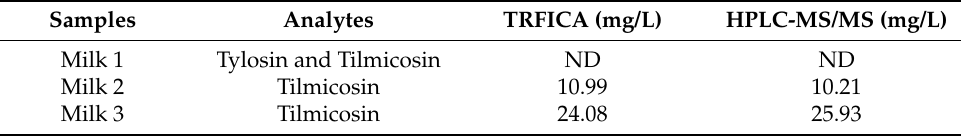
Table 5. The results between TRFICA and HPLC-MS/MS for blind